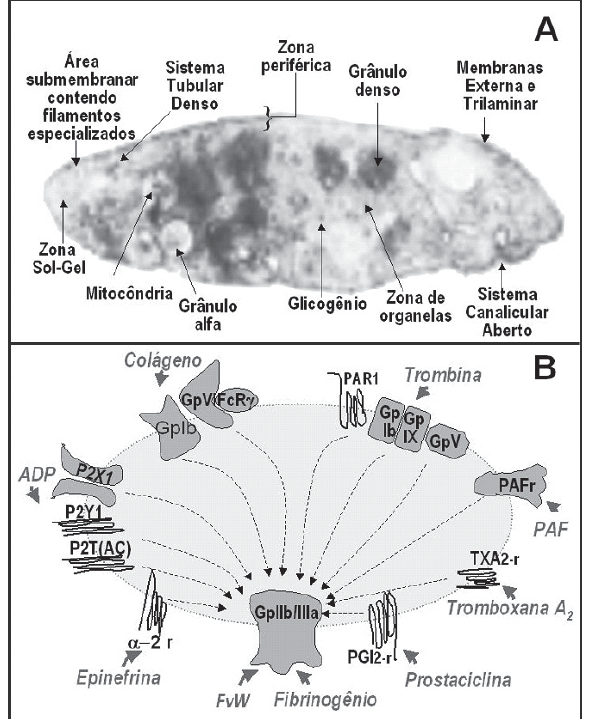
Figura 1 – A plaqueta. A: componentes e organização; B: receptores (preto) e agonistas